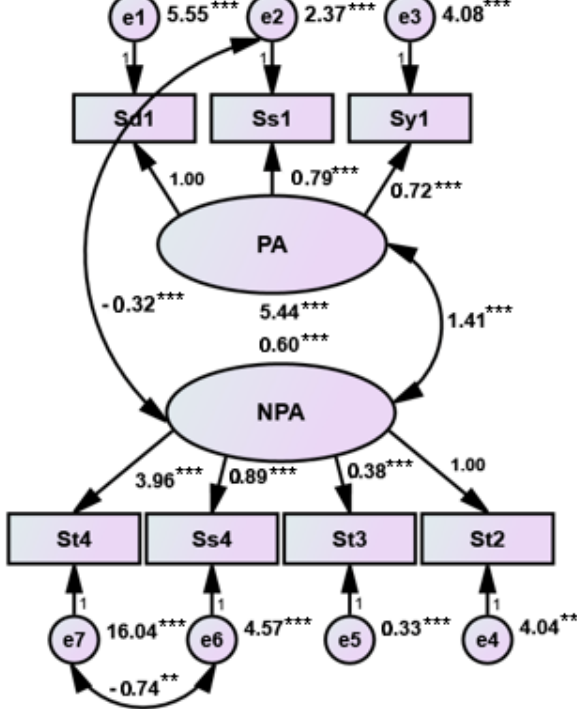
Figure 2. Cognitive skill measurement model (Note: ** p < 0.01. *** p < 0.001, two-tailed).